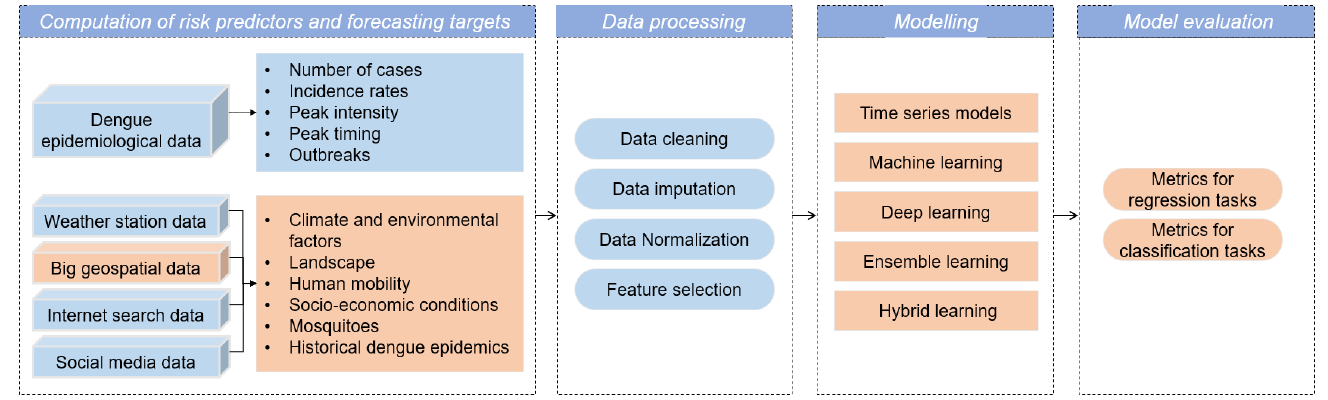
Figure 2. A general framework of dengue risk forecasting, in which the orange-filled rectangles indicate the key terms concerned in this review.